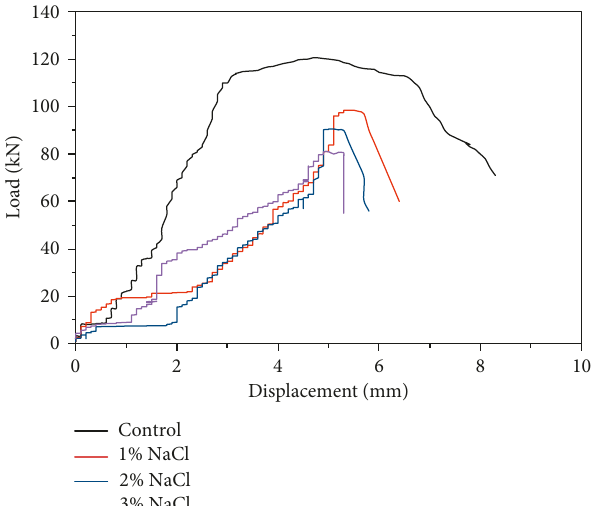
Figure 11: Load versus displacement behavior of corroded prestressed concrete beams after 30 days of exposure under various chloride levels.